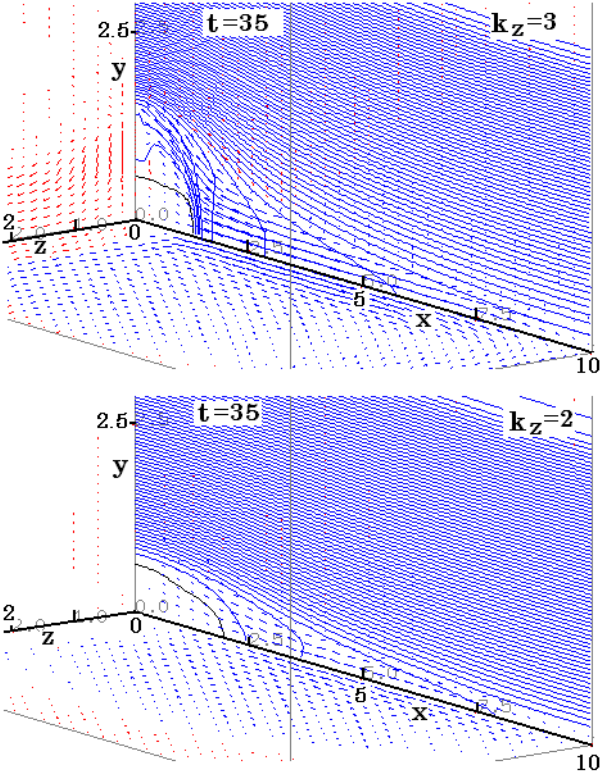
Fig. 4. Magnetic field and plasma flow configuration for the anoma- lous resistivity model (Eq. 4) with V C = 4 for the cases k z = 2 and 3 in Eq. (5).